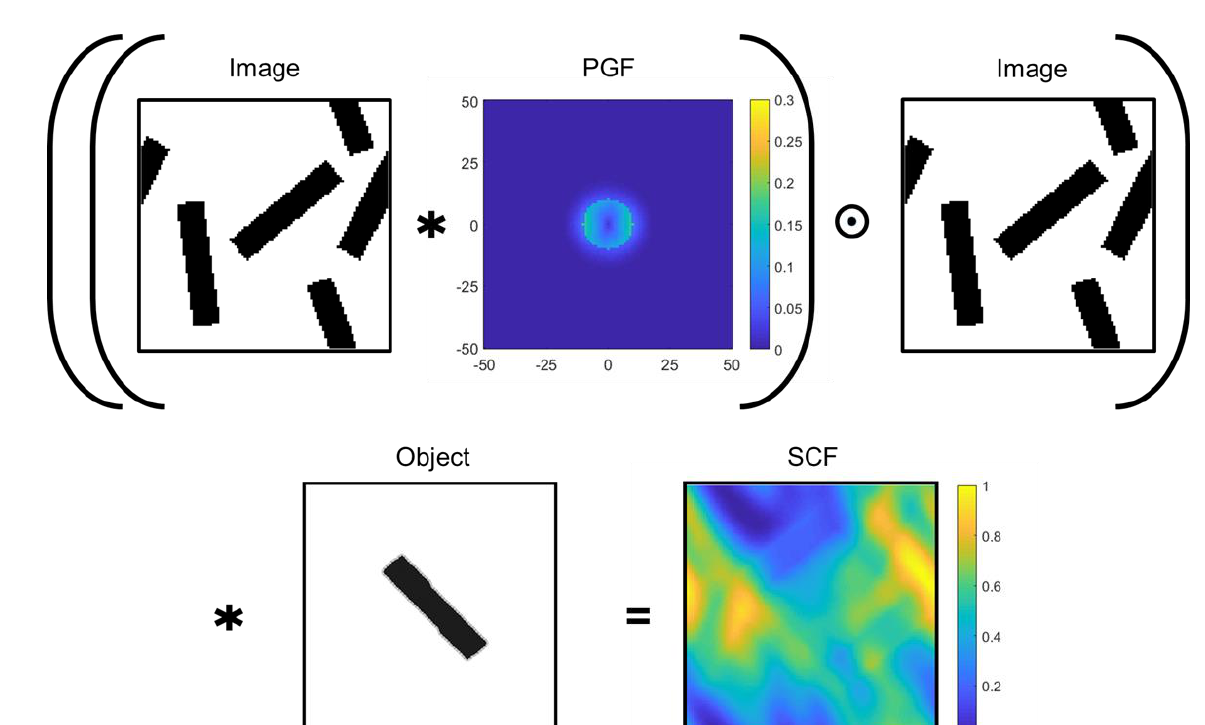
Figure 9. Graphical depiction of the operations involved in the calculation of the SCF (see Equation (8)).